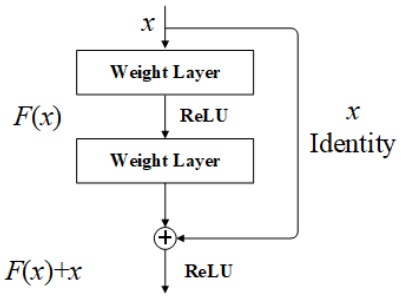
Figure 2. A residual block structure